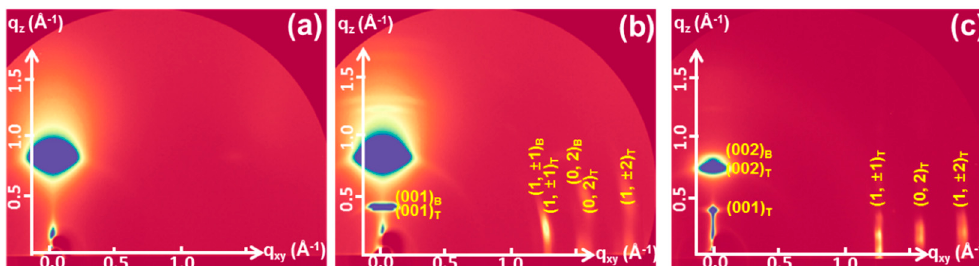
Figure 5. Two-dimensional grazing incidence X-ray diffraction (2D-GIXD) scan images of ( a ) GO film, ( b ) pentacene films deposited on GO, and ( c ) GO/PS dielectric. Subscripts “T” and “B” represent “thin-film phase” and “bulk phase,” respectively.